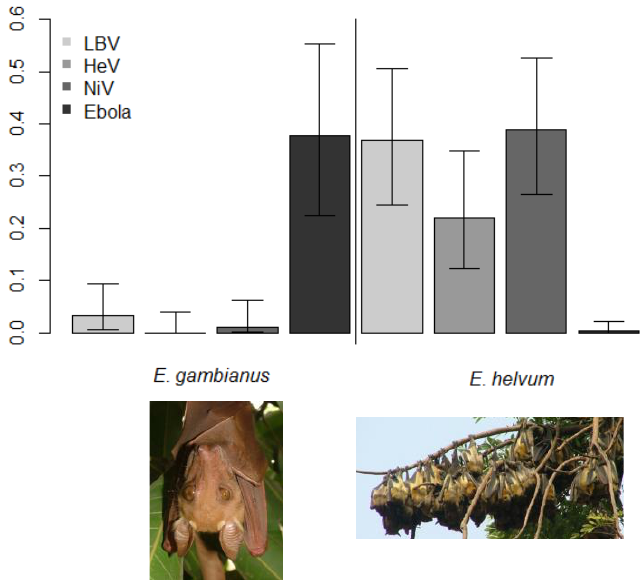
Figure 2. Differing antibody prevalence (as a proportion) from cross-sectional studies of two bat species from Ghana, West Africa. Epomophorus gambianus ( left , Gambian epauletted fruit bat) roosts in low density, is non-migratory and has a high seroprevalence of anti- Ebolavirus antibodies. Eidolon helvum ( right , Straw-colored fruit bat) roosts in high density, is migratory and has a low seroprevalence of anti-Ebolavirus antibodies, but high seroprevalence of antibodies against other RNA viruses. The viruses are: Lagos bat virus (LBV), Hendra virus (HeV), Nipah virus (NiV), and Ebolavirus (Ebola). Results are adapted from